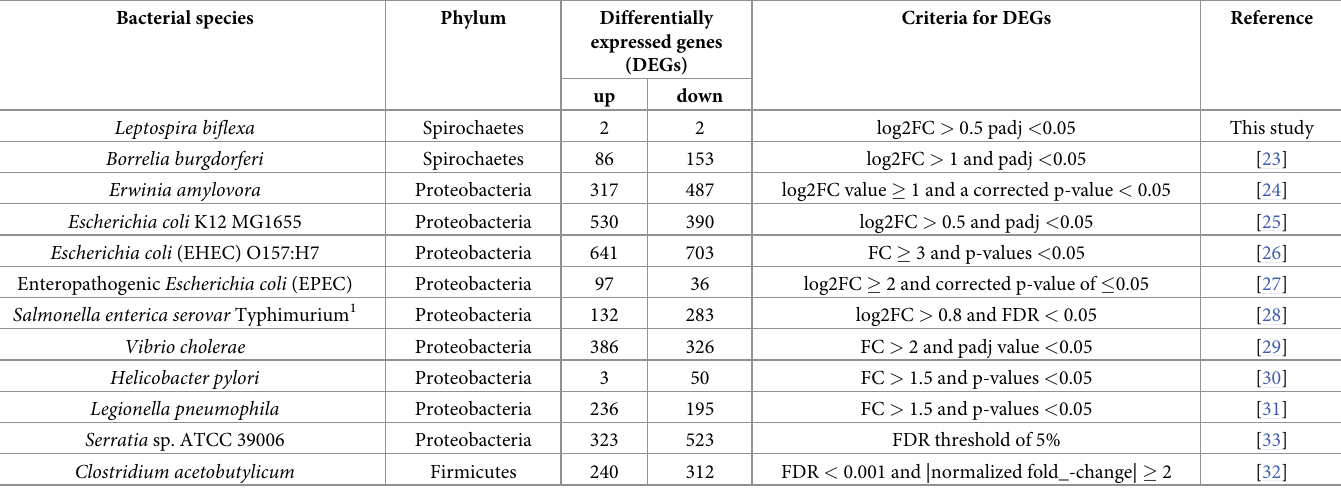
Table 1. Comparison of differentially expressed genes in csrA mutants. Bacterial